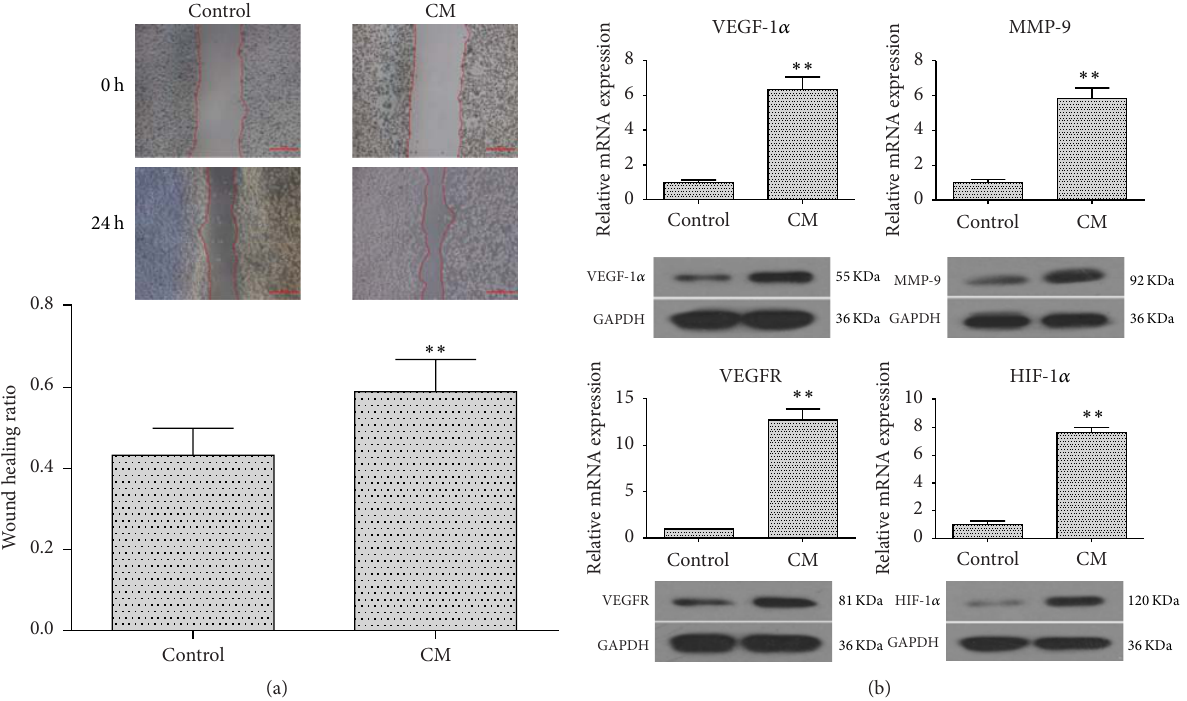
Figure 5: Conditioned culture of HUVECs promoted their migration and angiogenic differentiation. HUVECs were cultured in CM for 72 h. (a) The significantly reduced wound area by CM. (b) The markedly upregulated expression of VEGF-1 𝛼 , MMP-9, VEGFR, and HIF-1 𝛼 by CM. Data are presented as means ± SD from three independent experiments. ∗∗ represents 𝑝 < 0.01 ; scale bars: 500 𝜇